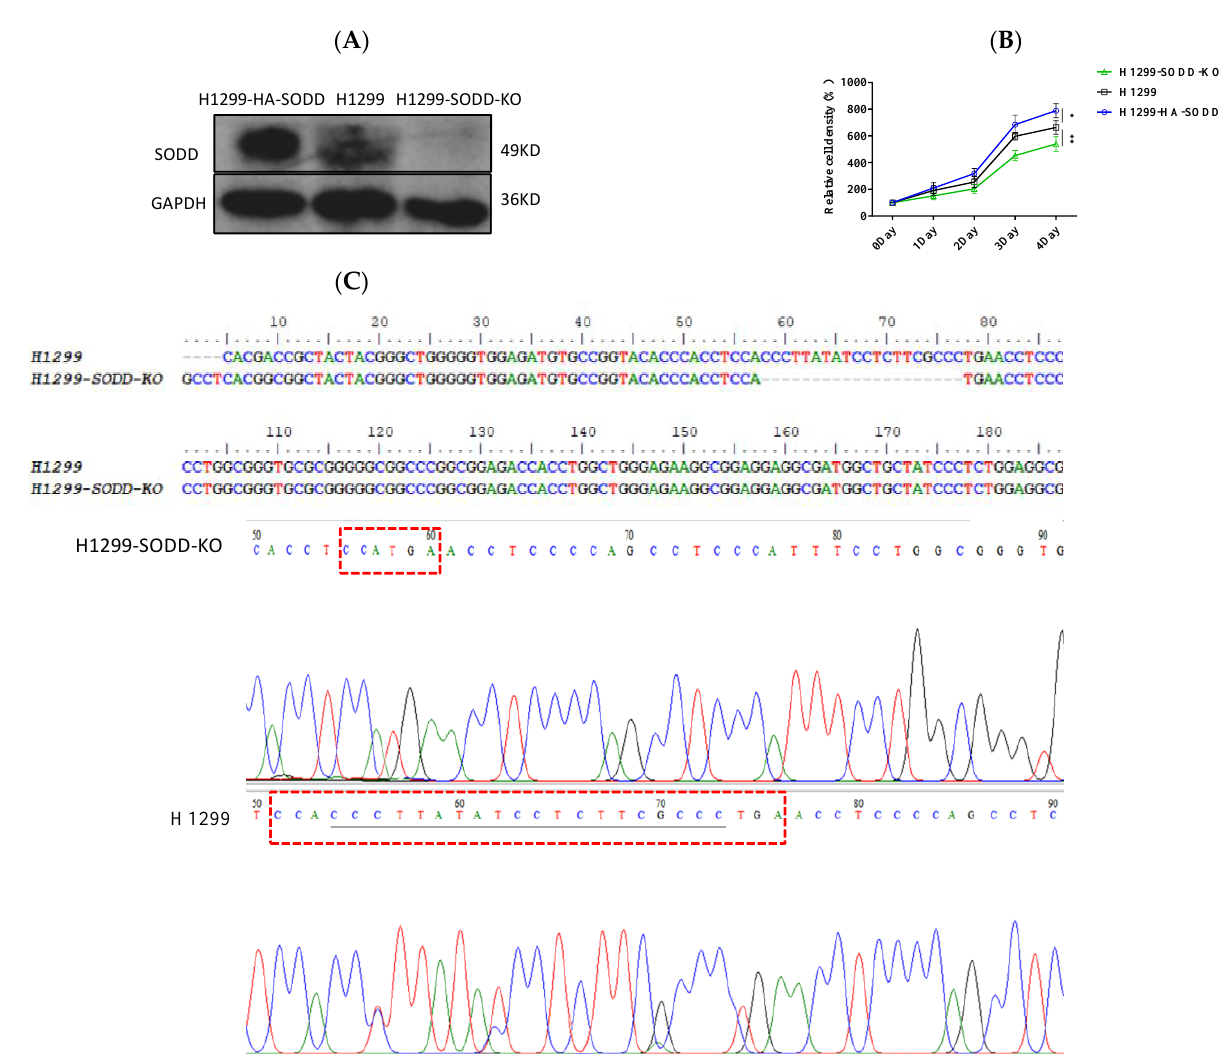
Figure 2. Establishing a SODD knockout (KO) and overexpressed (HA-SODD) H1299 cell line and exploring the effect of SODD on H1299 cell growth. ( A ) SODD expression in SODD (KO), HA-SODD, and H1299 cells was detected by Western blotting ( B ) SODD promotes the proliferation of H1299 cells. The overexpression of SODD could promote the growth of H1299 cells, whereas the knockout of H1299 could inhibit it. (* p < 0.05, ** p < 0.01 vs. control) ( C ) The DNA sequencing of SODD-KO (SODD −/− ) and WT H1299 cells served to confirm SODD knockout. The missing bases are underlined in the red box.